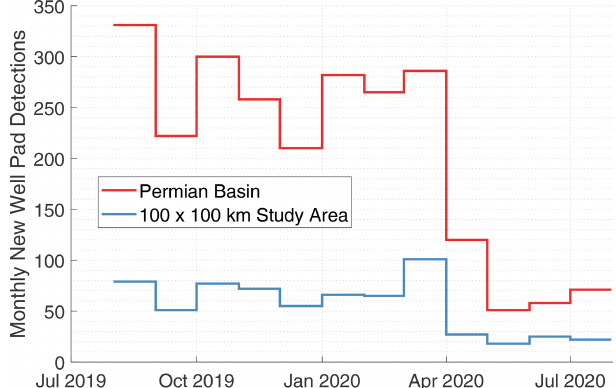
Figure 7. Number of new well pads constructed per month be- tween 1 August 2019 and 31 July 2020 in the full Permian Basin and our 10000km 2 Delaware subbasin study area based on satellite imagery and machine learning (Appendix C).